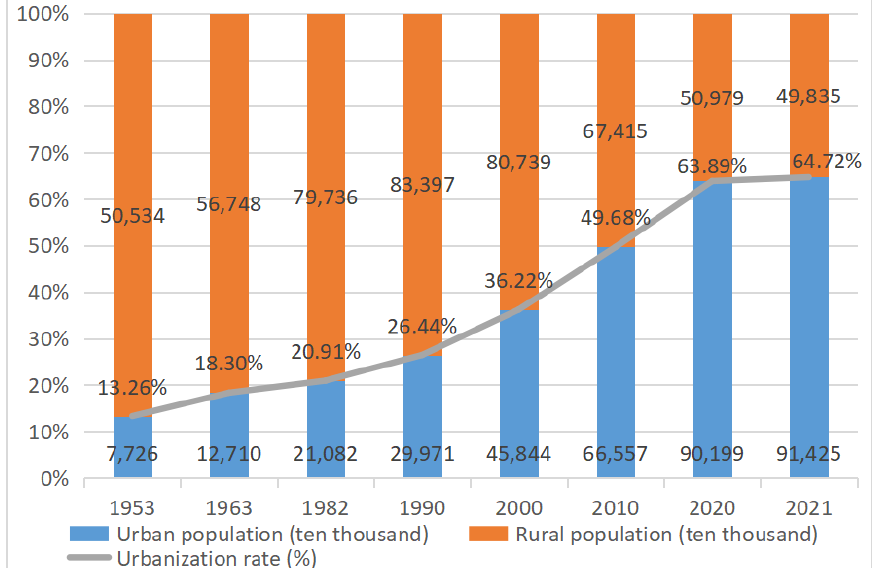
Figure 1. Urbanization rate in China.